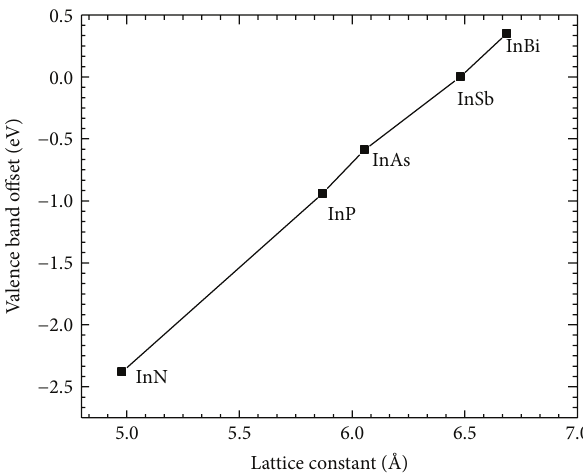
Figure 1: Plot of valence band offset versus lattice constant for In- containing III-V binaries. The values of VBO and lattice constants for these compounds are obtained from